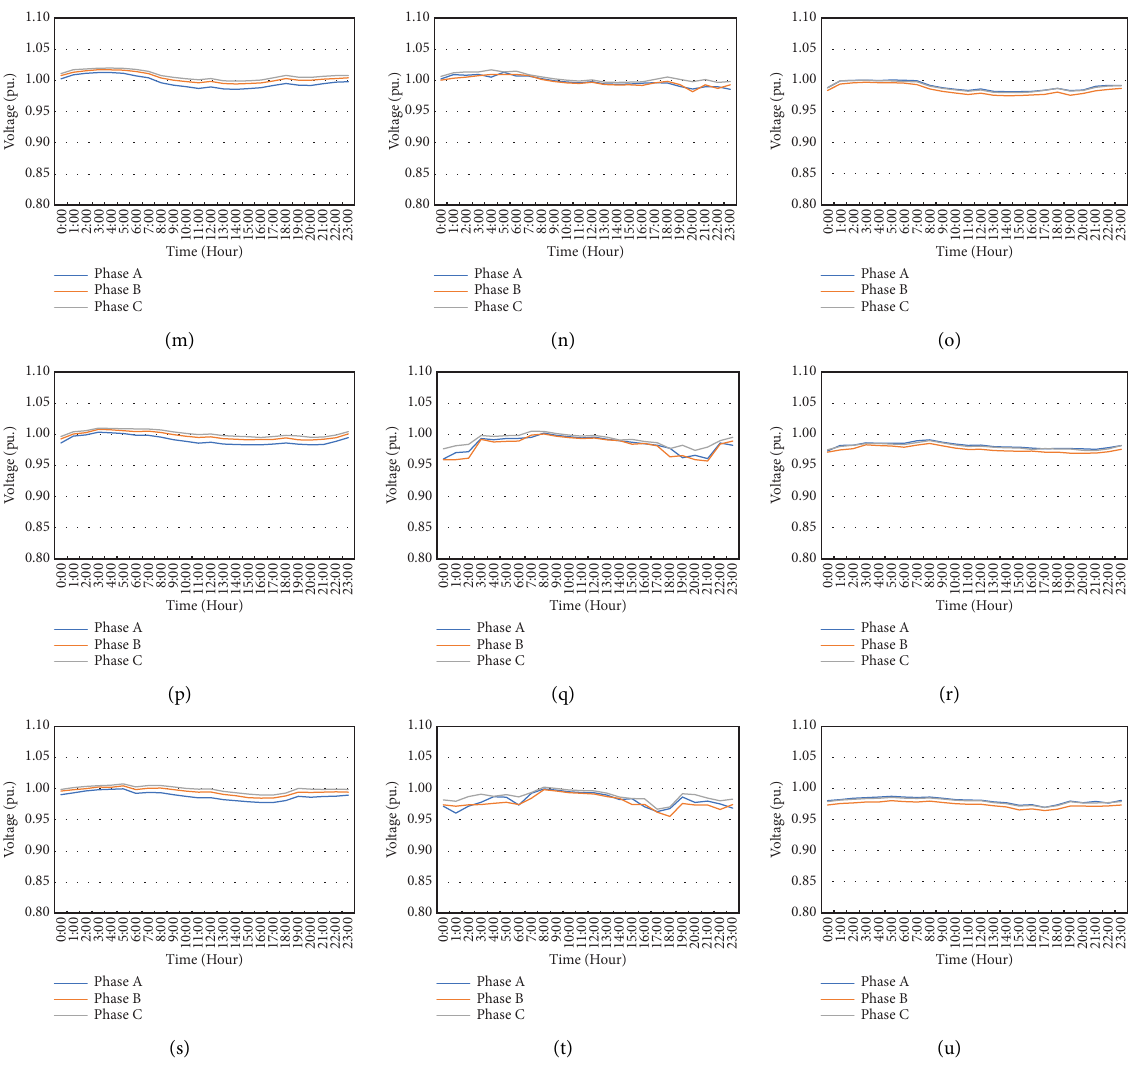
Figure 28: Daily voltage profles at the end of feeders no. 1, 4, and 5 for uncoordinated and smart charging with base case and EV penetration of 10%, 30%, and 50%. (a) Feeder no. 1 (base case). (b) Feeder no. 4 (base case). (c) Feeder no. 5 (base case). (d) Feeder no. 1 (uncoordinated charging with EV penetration of 10%). (e) Feeder no. 4 (uncoordinated charging with EV penetration of 10%). (f) Feeder no. 5 (uncoordinated charging with EV penetration of 10%). (g) Feeder no. 1 (uncoordinated charging with EV penetration of 30%). (h) Feeder no. 4 (uncoordinated charging with EV penetration of 30%). (i) Feeder no. 5 (uncoordinated charging with EV penetration of 30%). (j) Feeder no. 1 (uncoordinated charging with EV penetration of 50%). (k) Feeder no. 4 (uncoordinated charging with EV penetration of 50%). (l) Feeder no. 5 (uncoordinated charging with EV penetration of 50%). (m) Feeder no.1 (smart charging with EV penetration of 10%). (n) Feeder no. 4 (smart charging with EV penetration of 10%). (o) Feeder no. 5 (smart charging with EV penetration of 10%). (p) Feeder no. 1 (smart charging with EV penetration of 30%). (q) Feeder no. 4 (smart charging with EV penetration of 30%). (r) Feeder no. 5 (smart charging with EV penetration of 30%). (s) Feeder no. 1 (smart charging with EV penetration of 50%). (t) Feeder no. 4 (smart charging with EV penetration of 50%). (u) Feeder 5 (smart charging with EV penetration of